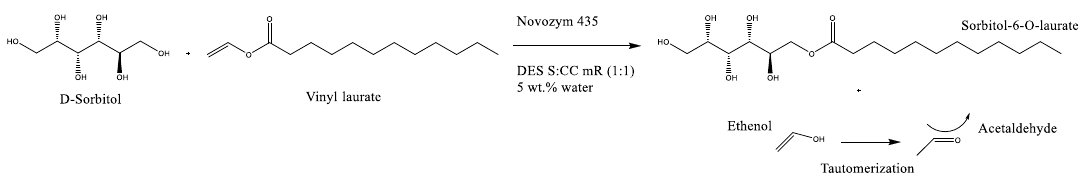
Figure 1. Lipase-catalyzed transesterification reaction between D-sorbitol and vinyl laurate. Evaporation of highly volatile acetaldehyde makes the conversion irreversible. S: Sorbitol; CC: Choline Chloride; mR: molar